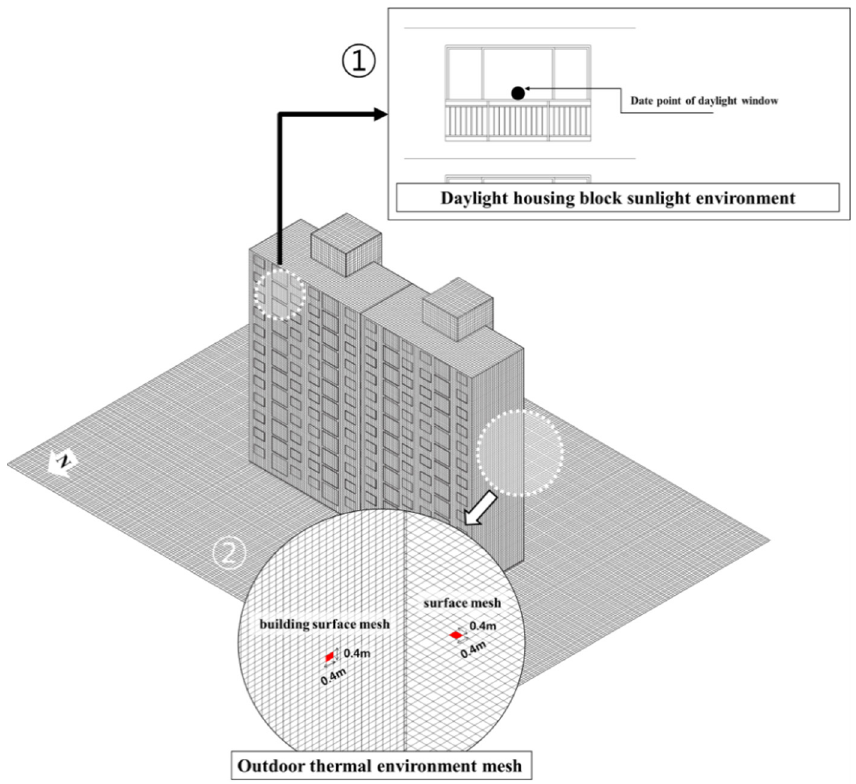
Figure 3. Simulation